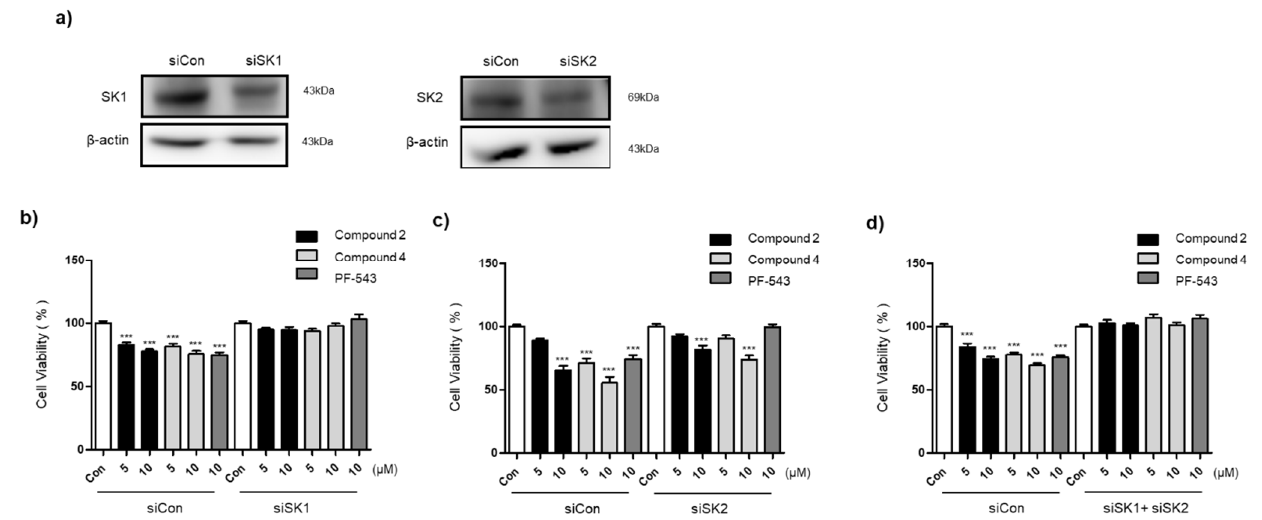
Figure 5. Cell cytotoxic effect of Compounds 2 and 4 by inhibiting SK1 and SK2 expression. A549 cells were transiently transfected with control siRNA or SK1, SK2 siRNA for 24 h; ( a ) The protein expression level of SK1 and SK2 was confirmed by Western blot; ( b – d ) Cells transfected with siSK1, siSK2 or siSK1 + siSK2 were treated with Compounds 2 and 4 and FP-543 for 24 h, respectively, and cell viability was measured using EZ-CYTOX. Data are expressed as the mean ± S.D. *** p < 0.001 compared with control group.